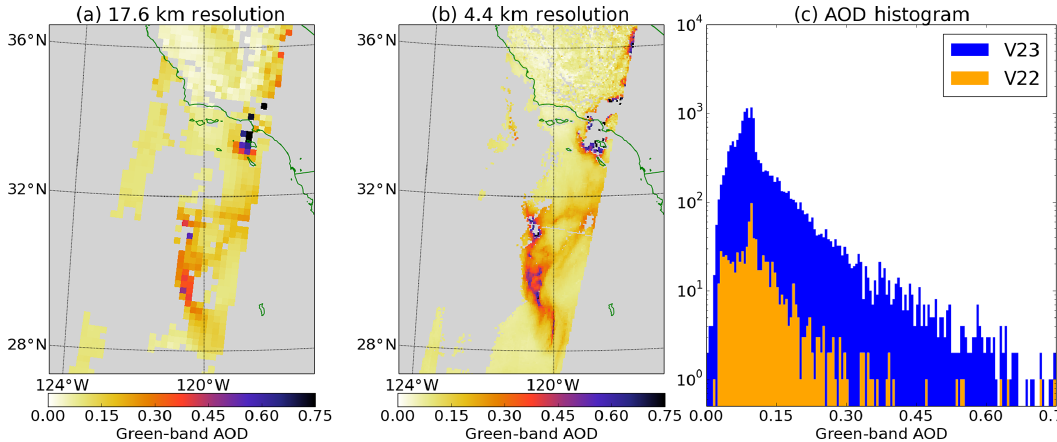
Figure 4. Comparison of V22 and V23 AOD retrievals for 23 July 2016 (orbit 88284): (a) V22 AOD map, (b) V23 AOD map, and (c) AOD histograms.